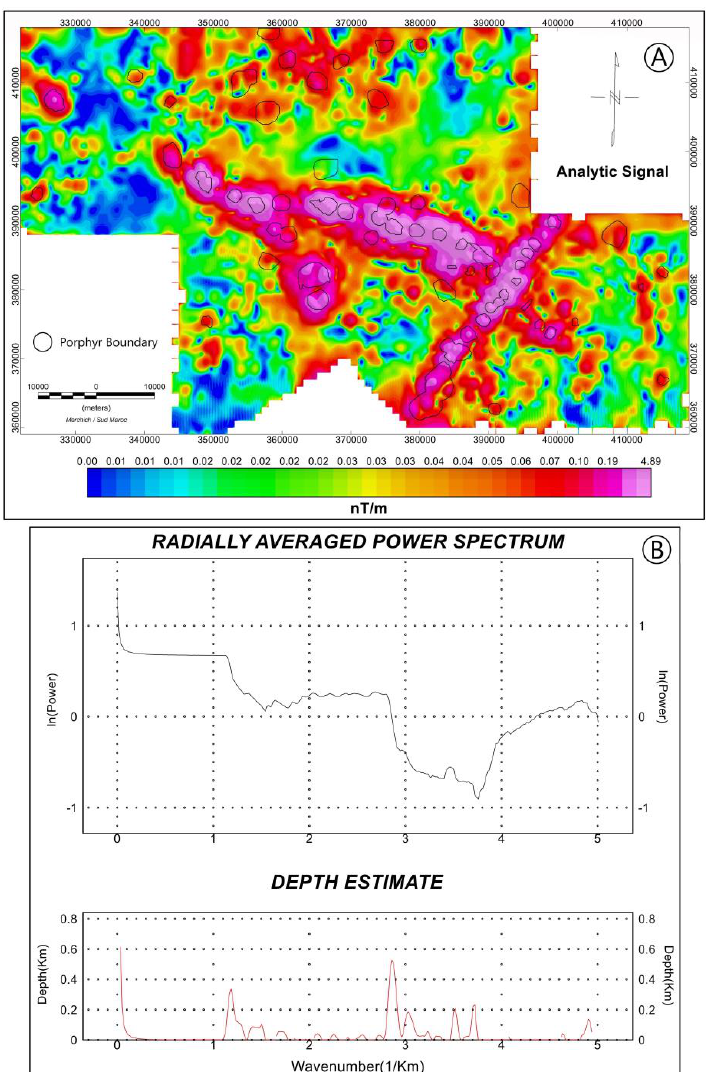
Figure 17. ( A ) Analytic signal map with contour boundaries of the existent and probable porphyry. ( B ) Depth estimation of magnetic sources by analytic signal spectrum.